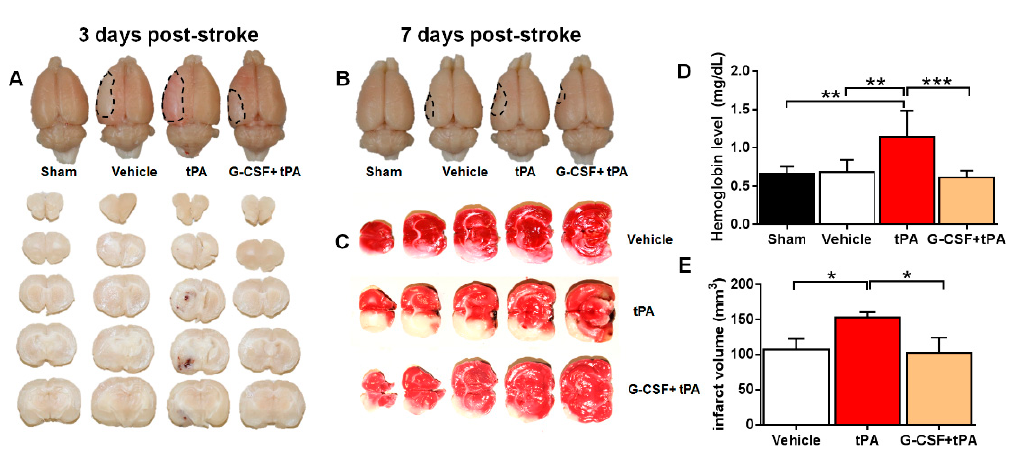
Figure 1. Effects of granulocyte-colony stimulating factor (G-CSF) on delayed tissue plasminogen activator (tPA)-induced hemorrhage and cerebral infarction in rats subjected to thromboembolic stroke. ( A ) Photographs are representative coronal brain sections obtained 3 days after stroke, showing that tPA treatment produced remarkable hemispheric hemorrhage, whereas the combined treatment with G-CSF did not result in bleeding; ( B ) Infarct volume was reduced, and hemorrhage was not observed in rats treated with G-CSF 7 days after stroke; ( C ) Representative coronal brain sections stained with 2,3,5-triphenyltetrazolium chloride (TTC) 3 days after stroke showing the infarct area (white) and intact areas (red); ( D ) Quantitative analysis of spectrophotometric assay findings showing the incidence of hemorrhage in rats subjected to delayed tPA treatment, which was reduced by 47% by G-CSF treatment; ( E ) Quantitative analysis of infarct volume in vehicle-, tPA-, and G-CSF + tPA-treated groups. G-CSF reduced infarct volume by 33% in stroked rats subjected to delayed tPA treatment; * p < 0.05, ** p < 0.01, *** p < 0.001, n = 7 rats per group. The data are expressed as mean ± S.E.M.